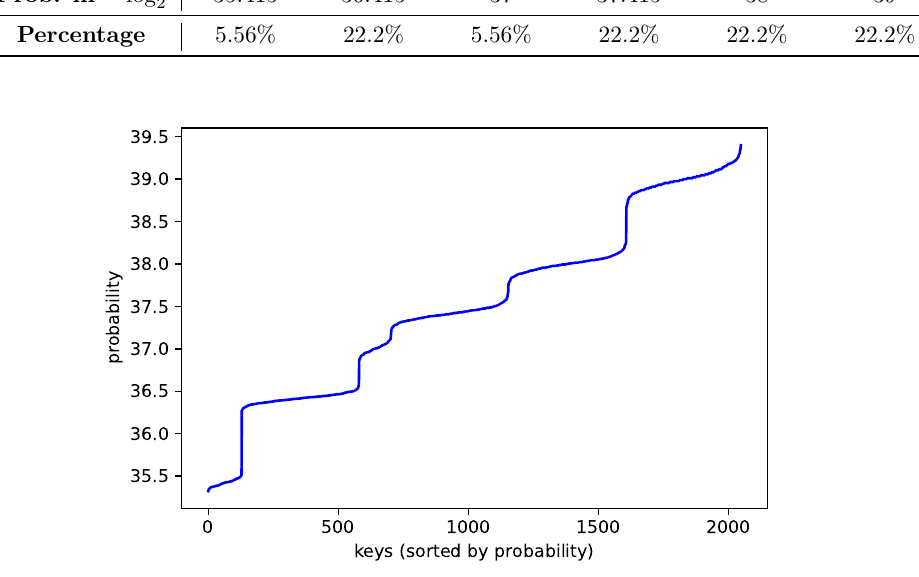
notation) of the differential 2